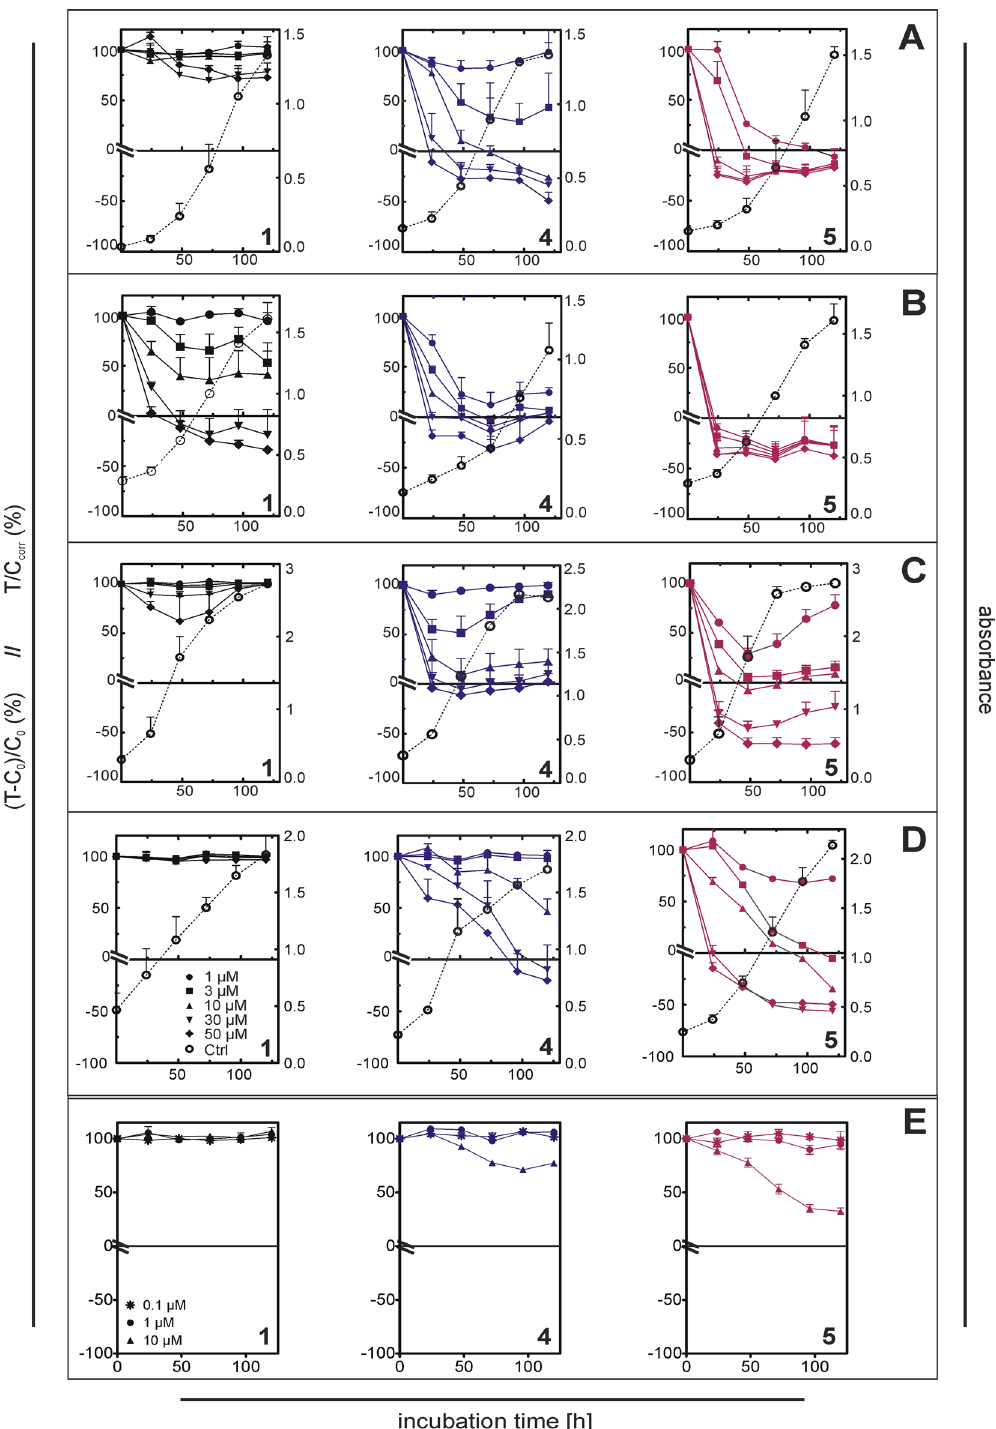
Fig 2. Antiproliferative activity of compounds 1, 4 and 5 against selected malignant tumor cells and spontaneously immortalized human keratinocytes upon long-term incubation. Jurkat (A; acute T cell leukemia), SK-ES-1 (B; Ewing ’ s sarcoma), NCI-H460 (C; large cell lung cancer) and HT- 29 (D; colorectal cancer) cells were treated with compounds 1, 4 and 5 at concentrations between 1 μ M and 50 μ M, HaCaT cells (E; spontaneously immortalized human keratinocytes) were incubated with 1 , 4 and 5 at 0.1, 1 and 10 μ M. Incubation period: 5 days. Antiproliferative and cytotoxic effects correspond to the left y-axes. The growth curves of untreated control cells (open circles) correspond to the right y-axes. Data are mean values ± SEM of at least 2 independent assays with 8 replicates per compound concentration. For additional data on long-term cytotoxity of compounds 1 – 7 against various tumor cell types and cytotoxicity of compound 2 against HaCaT cells cf. S3 – S13 Figs.